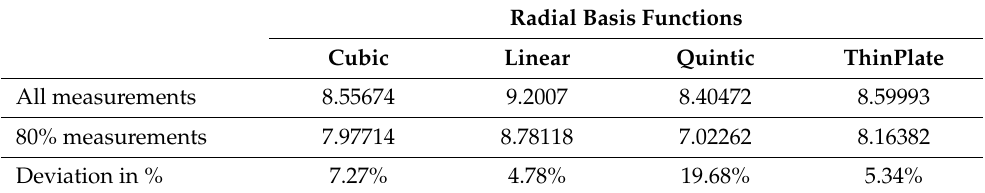
Table 1. Radiation doses when moving along the detected optimal route, visiting the specified points of room “ B ”,